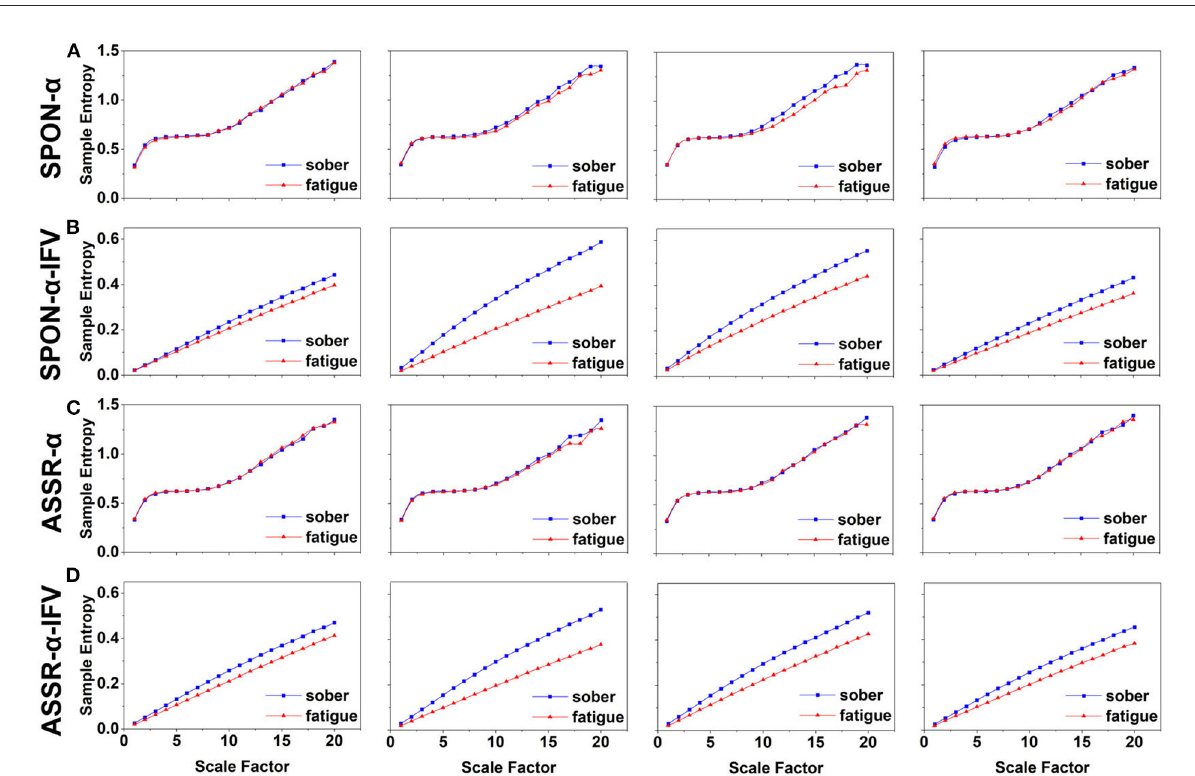
FIGURE2 MSE analysis of SPON- α (A) , ASSR- α (B) , SPON- α -IFV (C) , and ASSR- α -IFV (D) on frontal lobe (channel F3) from four exemplary subjects. The blue and red lines represent the Sober and MF states, respectively. See Section 2.5 for the definitions of